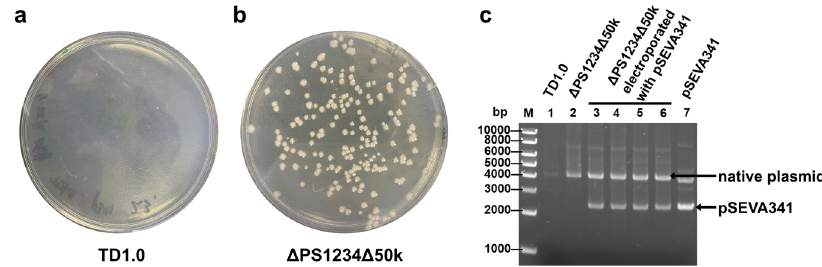
Fig. 8 Electrotransformation of TD1.0 and Δ PS1234 Δ 50k. a , b Cells were electrotransformed with 500 ng of pSEVA341. The LB60 agar plates (25 μ g/mL of chloramphenicol) were incubated at 37 °C for 48 h. c Agarose gel electrophoresis of the plasmid extracted from TD1.0, Δ PS1234 Δ 50k, and electrotransformed Δ PS1234 Δ 50k. The black arrows show the bands of the native plasmid from H. bluephagensis and pSEVA341, respectively. TD1.0, H . bluephagenesis TD1.0; Δ PS1234 Δ 50k, H . bluephagenesis TD1.0 with deletion of PS1, PS2, PS4, and PS3 gene clusters and fl agellar gene cluster.